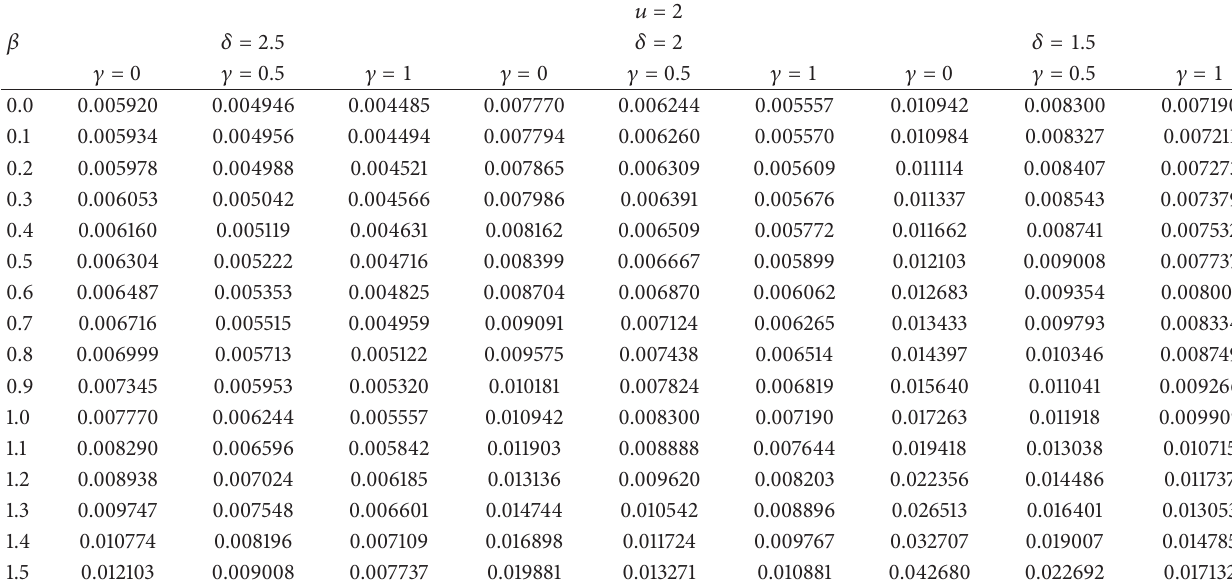
Table 3: Exact values of 𝜙 2 (𝑢) under different stochastic interest